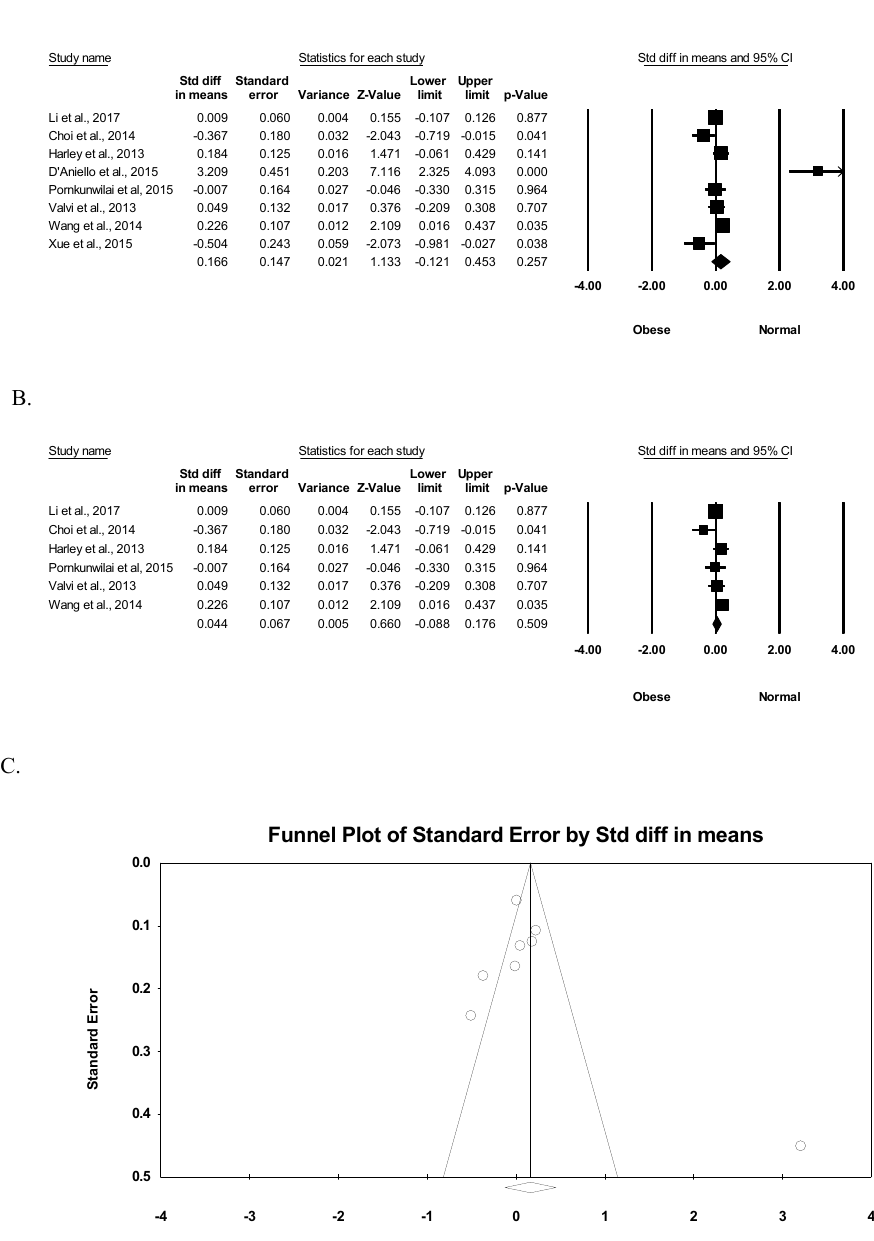
Figure 2. Meta ‐ analysis of childhood obesity by exposed group. ( A ) Forest plot of seven data on the risk of childhood obesity by exposed group. ( B ) Forest plot of six data, except one pilot study on the risk of childhood obesity by exposed group. ( C ) Funnel study in the meta ‐ analysis on the association between BPA exposure and childhood obesity.